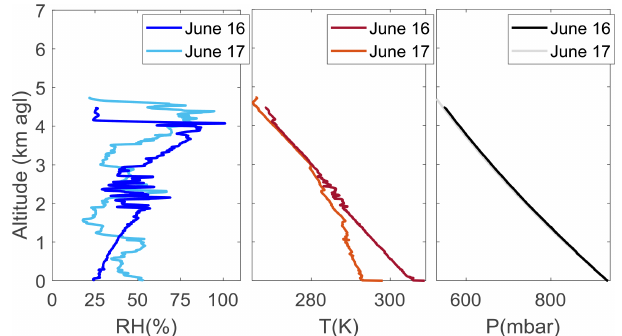
Figure 1. Relative humidity (RH), temperature ( T ), and pres- sure ( P ) profiles measured on board the ATR during flights F30 (16 June) and F31 (17